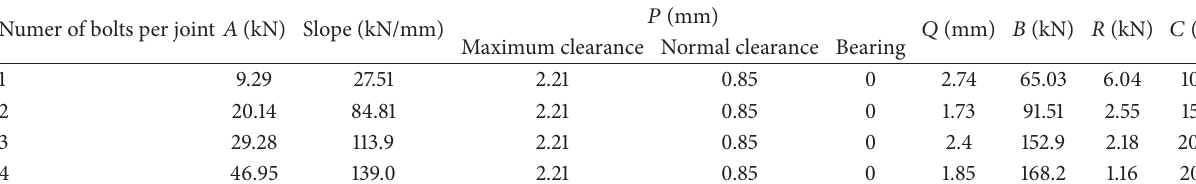
Table 1: Ungkurapinan et al. single-leg bolted joint [18].